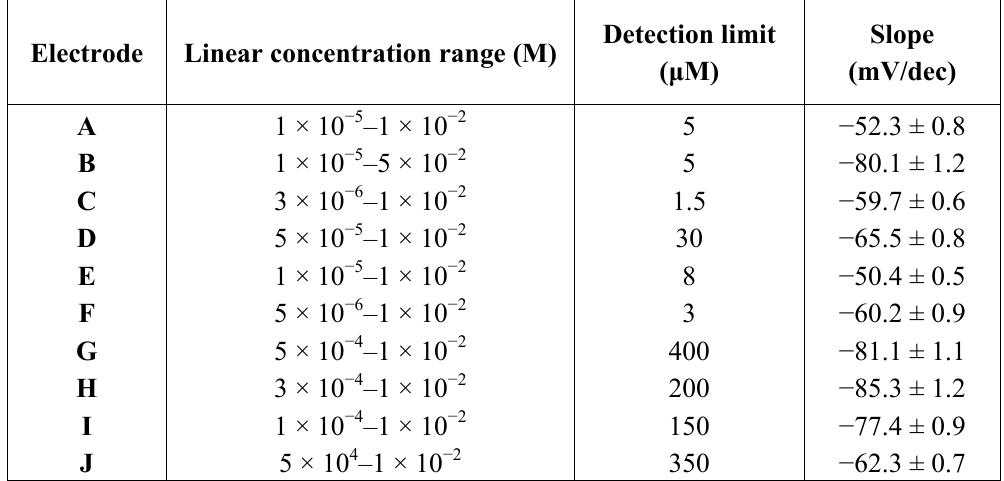
Table 2. General working characteristics of the constructed sensors.